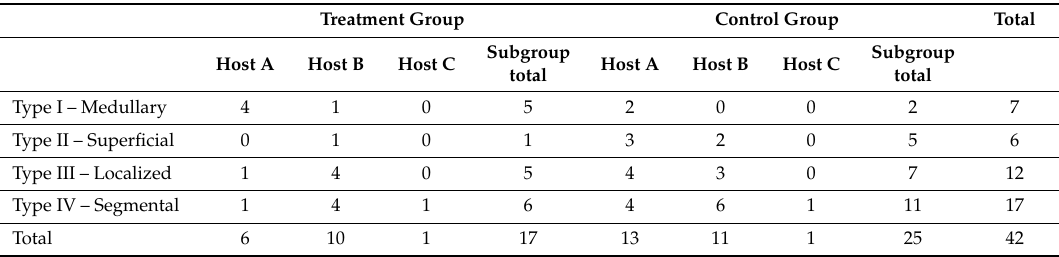
Table 2. Cierny–Mader classification of included